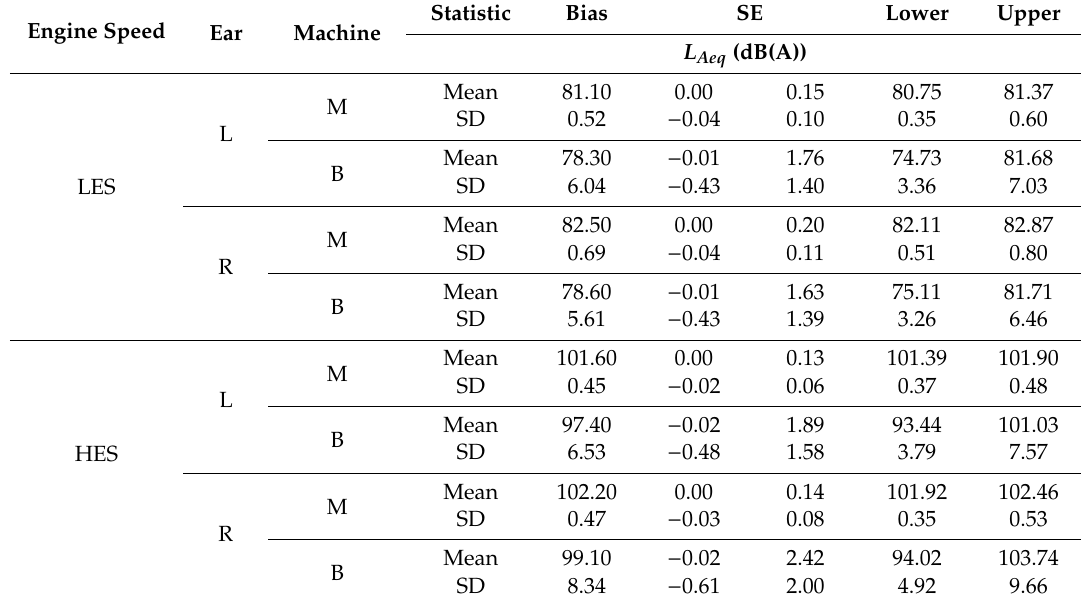
Table 5. The bootstrap method (1000 bootstrap samples) applied to the L Aeq data at the operators’ ears (left and right) using mist blowers and blowers at LES (low engine speed) and at HES (high engine speed).